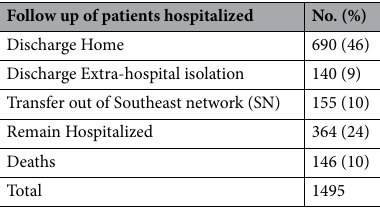
Table 1. Follow up of Patients Hospitalized With Coronavirus Disease in Health Centers of Southeast Network.